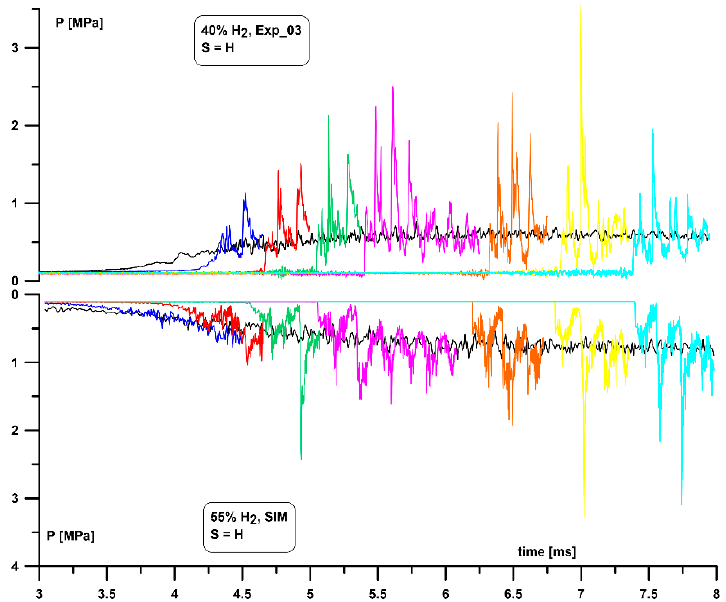
Figure 6. Experimental (top) and numerical (bottom) pressure profiles with deflagration for case S = H. Sequence of sensors activation corresponds to the sensors position as in Figure 1. Same colors apply to sensors in the same position. Simulation time shifted +2.5 ms for better visibility.